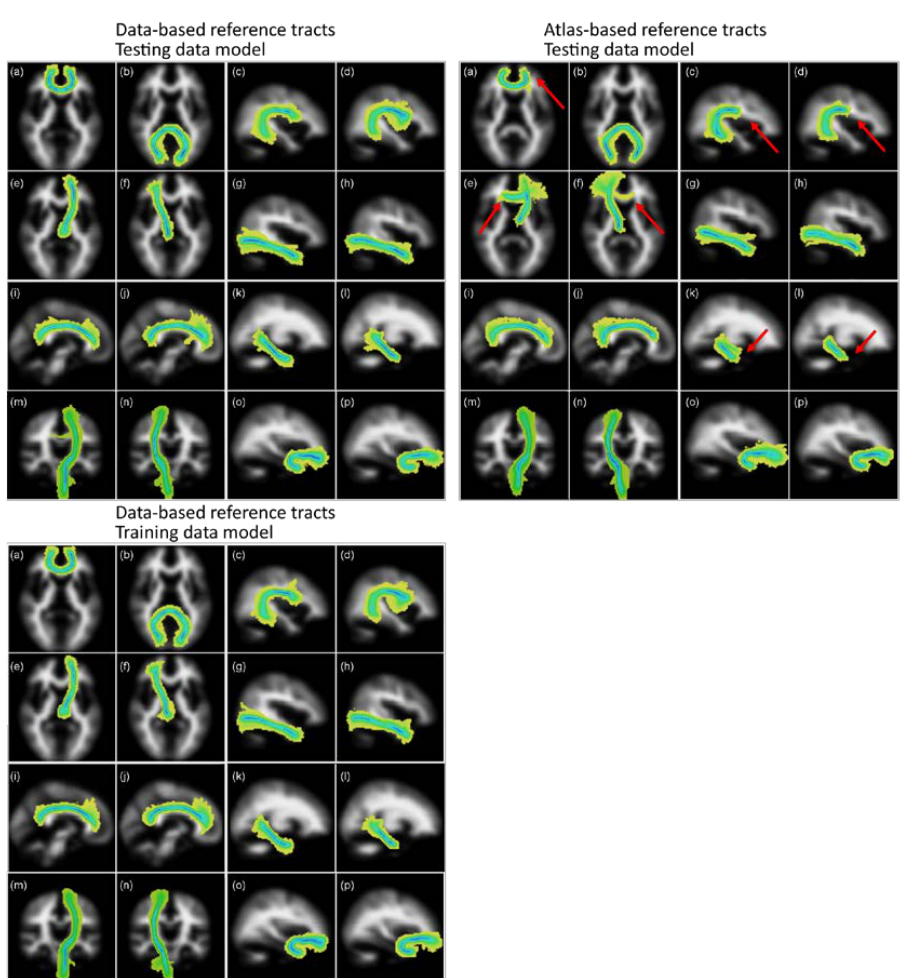
Figure 4. Group maps projections for the 16 tracts of interest segmented using the data-based (left panel) and atlas-based (right panel) reference tracts. Top panels used a matching model trained in the LBC1936 data, and the bottom panel used a model trained in the training data. The tracts represented are: ( a ) genu and ( b ) splenium of the corpus callosum, left and right arcuate fasciculus ( c , d ), left and right anterior thalamic radiation ( e , f ), left and right inferior longitudinal fasciculus ( g , h ), left and right dorsal ( i , j ) and ventral ( k , l ) cingulum, left and right corticospinal tracts ( m , n ) and left and right uncinate fasciculus ( o , p ). Color scale represents the voxel visitation frequency, from 1 (light yellow) to 50 (dark blue). Maps are projected into the plane of the voxel with maximum visitation value. Red arrows point at the main differences obtained between the resulting tracts derived from atlas-based and data-based reference tracts. Figure adapted from [1].